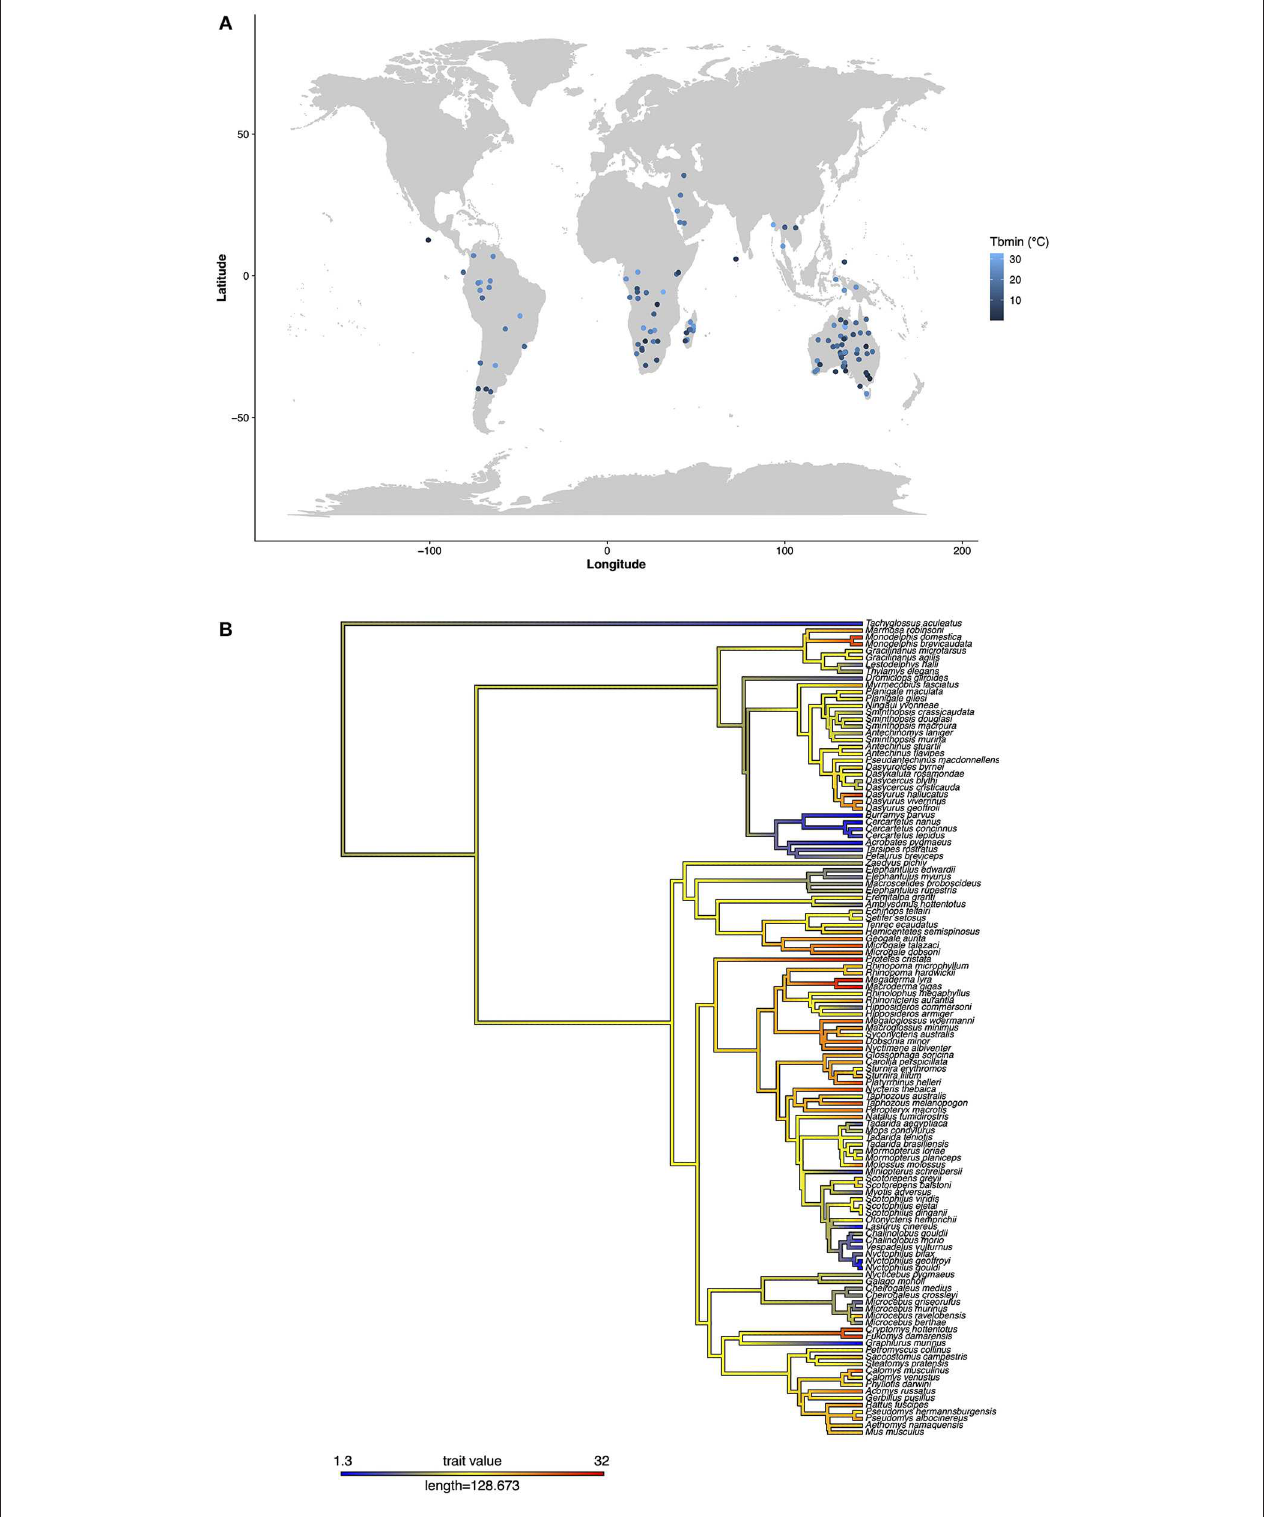
FIGURE 1 | (A) The minimum torpid body temperature (T b min) and phylogenetic relationship of non-Holarctic heterotherms, and (B) their geographical distribution. The phylogeny, including estimated ancestral states for T b min was plotted using “contMap” in the R library “phytools” (Revell, 2012) and the latest mammalian phylogeny by Upham et al. (2019). Geographical locations were taken as the latitude and longitude at the middle of the species range provided by the PanTHERIA dataset (Jones et al., 2009).